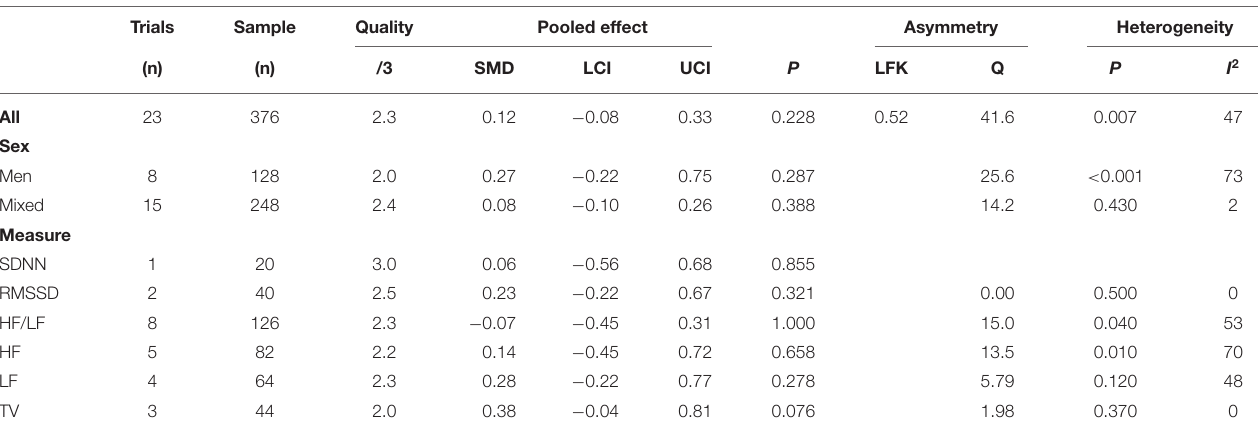
TABLE 4 | The effect of prolonged sitting on